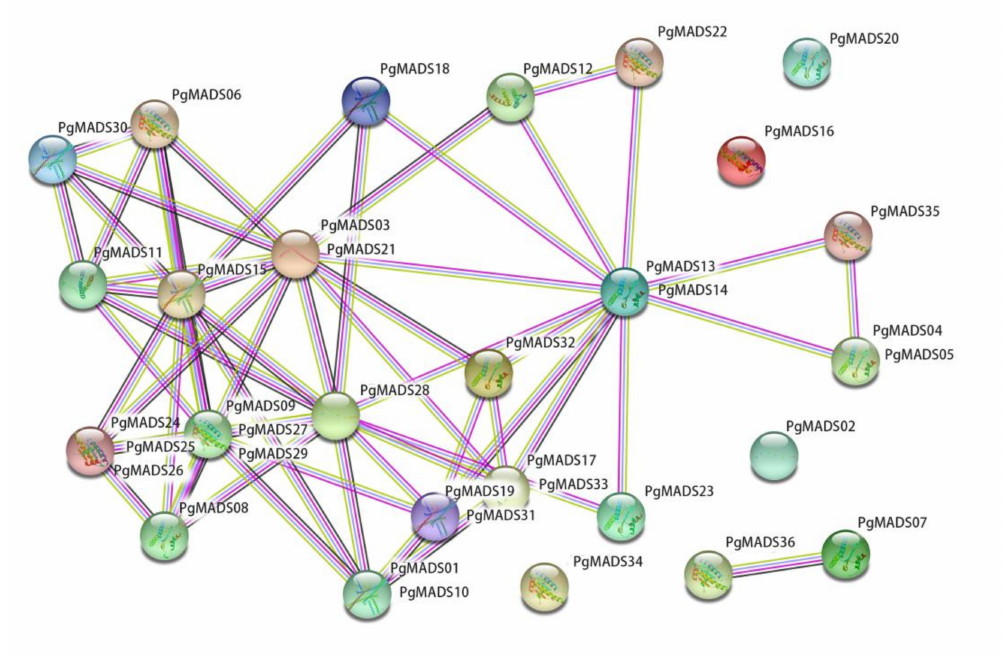
Figure 4. Protein-protein interaction network of MIKC-type MADS-box family in